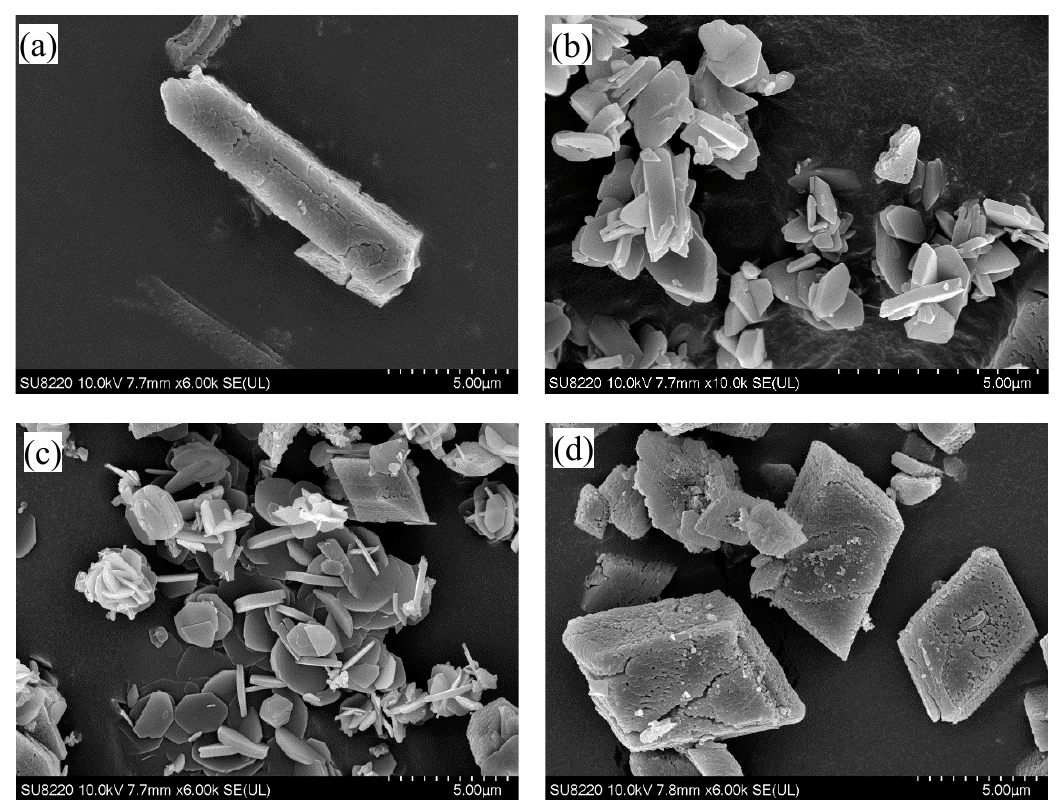
Figure 6. The decrease of (cid:3011) with increasing inhibitor concentration for the solutions in the presence (cid:3011) (cid:3116) of phytate for 𝑆 = 13.65 at 37 °C. The solid line is a visual